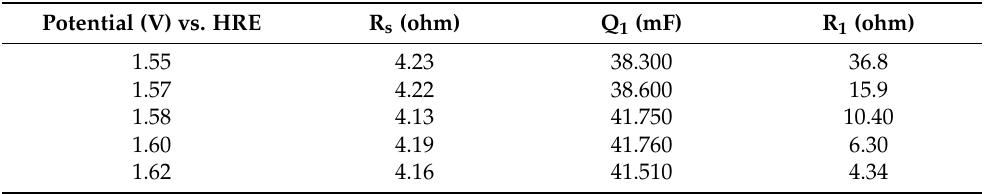
Table 5. Impedance parameter values derived from the fitting of the equivalent circuit for